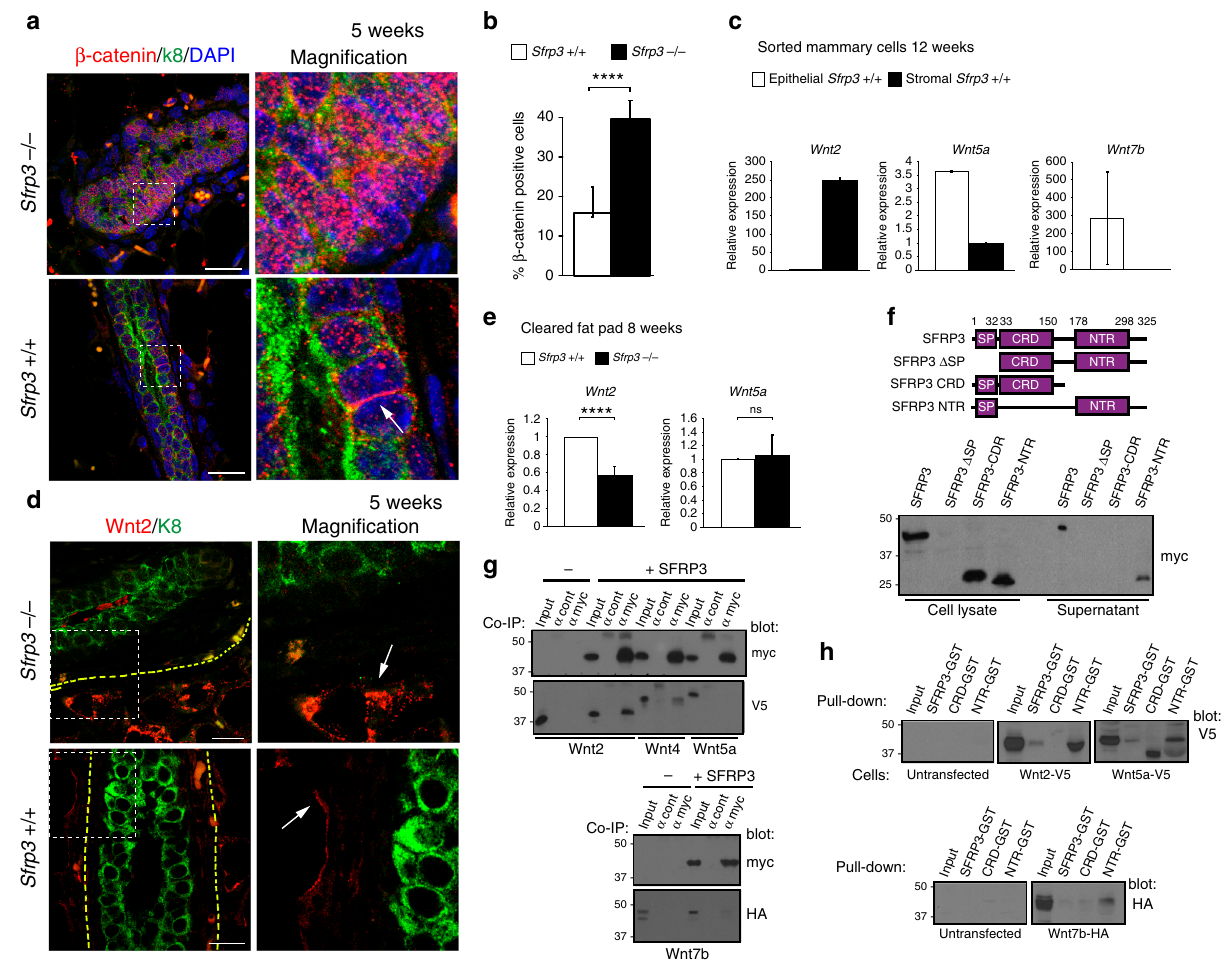
Fig. 6 Sfrp3 modulates Wnt signalling in the mammary gland. a Representative images of immuno fl uorescence staining for β -catenin (red), Troma (green) and nuclei (blue), on 5-weeks-old MG. Arrow denote localisation of β -catenin at cellular junctions in controls (Sfrp3 + / + ). Scale bar: 50 µ m. b Quanti fi cation of the number of β -catenin positive cells in mammary ducts of 5 weeks old Sfrp3 + / + ( n = 2, 5 mice) and Sfrp3 − / − ( n = 2, 8 mice) females. Data represent mean ± SD (**** p < 0.0001). c Relative mRNA level of Wnt2 (left), Wnt5a and Wnt7b (middle) and Wnt16 (right) in whole MG from Sfrp3 + / + and Sfrp3 − / − females at 10 weeks of age. n = 6. d Representative images of immuno fl uorescence staining for Wnt2 (red), K8 (green), on 5-weeks-old MG. Arrow denote localisation of Wnt2 at stromal-epithelial boundary. Images are representative of 3 MG sections analysed in 3 different experiments. Scale bar: 20 µ m. e Relative mRNA level of Wnt2 (left) and Wnt5a (right) in de-epithelialised cleared fat pad from Sfrp3 + / + and Sfrp3 − / − females at 8 weeks of age. n = 4. f Left, schemes of wild-type myc-tagged SFRP3 and truncated variants. Numbers indicate the aa position of each conserved domain according to UniProtKB database. SP, signal peptide; CRD, cysteine-rich domain; NTR, netrin-like domain. Right, western blot detection of SFRP3-myc in cell lysates and supernatants of MDCKII expressing different variants. The lack of SP domain abolishes protein expression. SFRP3-NRT variant is expressed and secreted, while SFRP3 CDR is expressed but not secreted in the medium. g Immunoprecipitation of SFRP3-myc followed by immunoblot with anti-myc, anti-V5 and anti-HA antibody in HEK293 cells transiently co-transfected with wild-type human SFRP3 construct and Wnt2-V5, Wnt5a-V5 and Wnt7b-HA constructs. α cont, cell lysate incubated with negative antibody conjugated beads; α myc, cell lysate incubated with anti-myc antibody conjugated beads. h Pull-down of GST-tagged forms of SFRP3 followed by immunoblot with anti-V5 and anti-HA antibody in HEK293 cells transfected with empty, Wnt2-V5, Wnt5a-V5 and Wnt7b-HA constructs. α cont, cell lysate incubated with negative antibody conjugated beads; α myc, cell lysate incubated with anti-myc antibody conjugated beads. For c , d , e , data represent mean ± SD (*** p < 0.001, **** p < 0.0001, ns, not signi fi cant). f – h blots are representative of 3 different experiments. Source data are provided as a Source Data fi